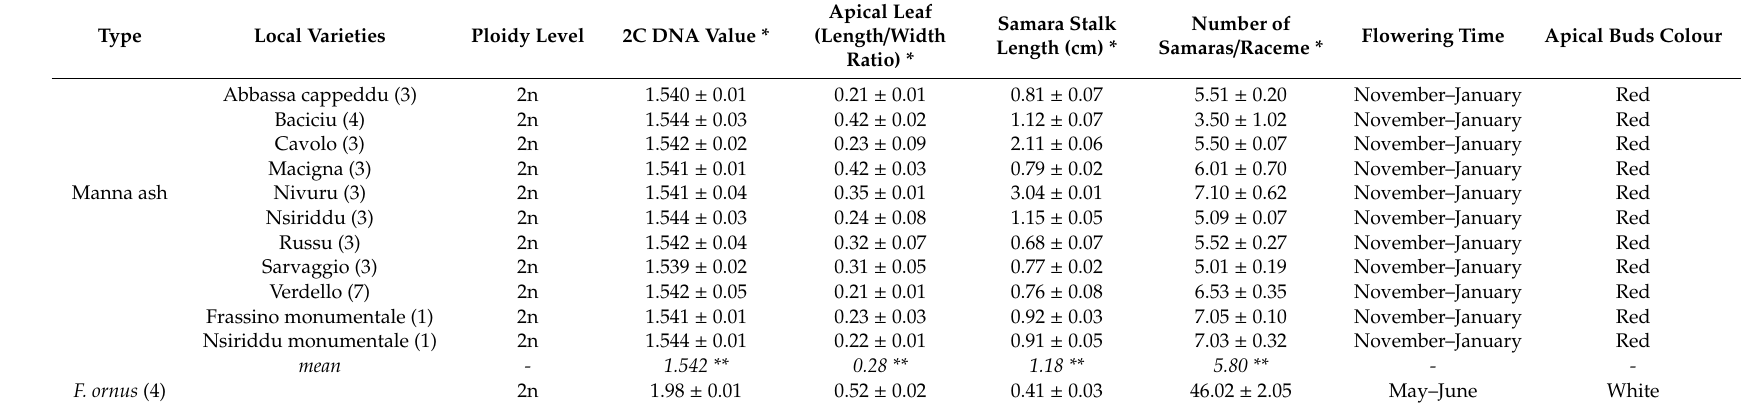
Table 1. Genome sizes and morphological traits of studied samples, belonging to manna ash collection. F. ornus was used as reference. In bracket the number of samples analyzed belonging to each local variety / species. Three replicates for each trait and the genome sizes evaluation were